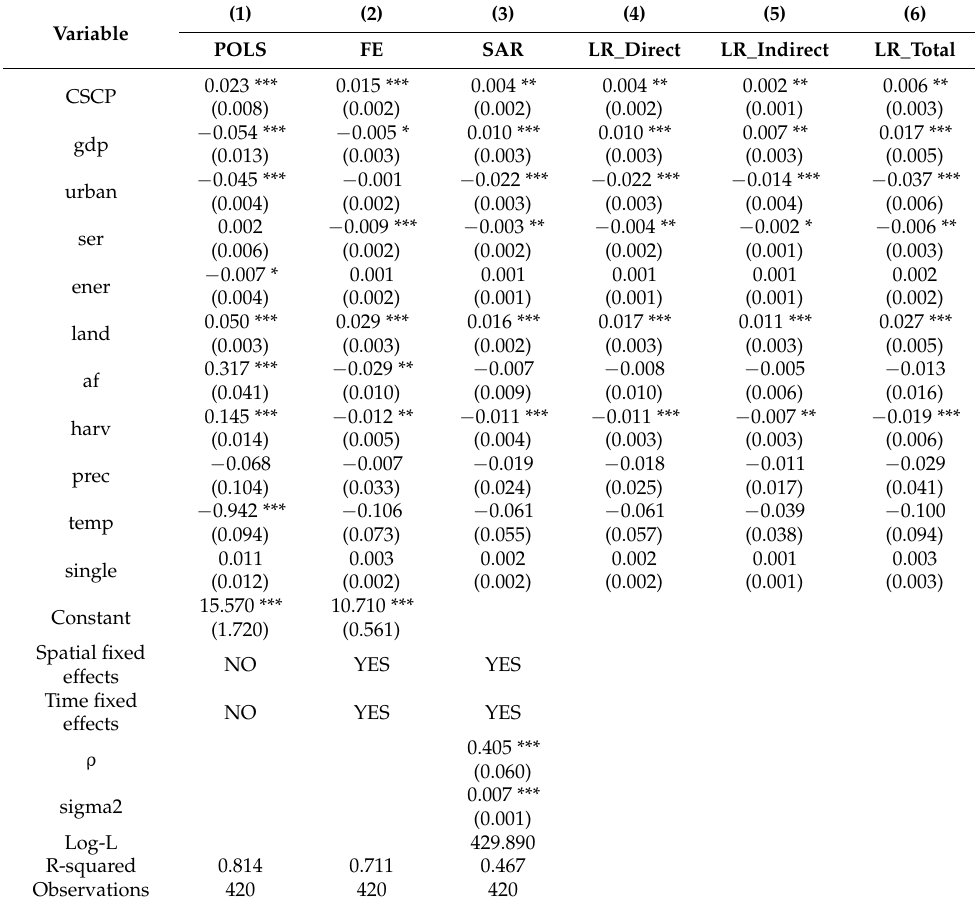
Table 4. Estimation results of benchmark regression and spatial panel